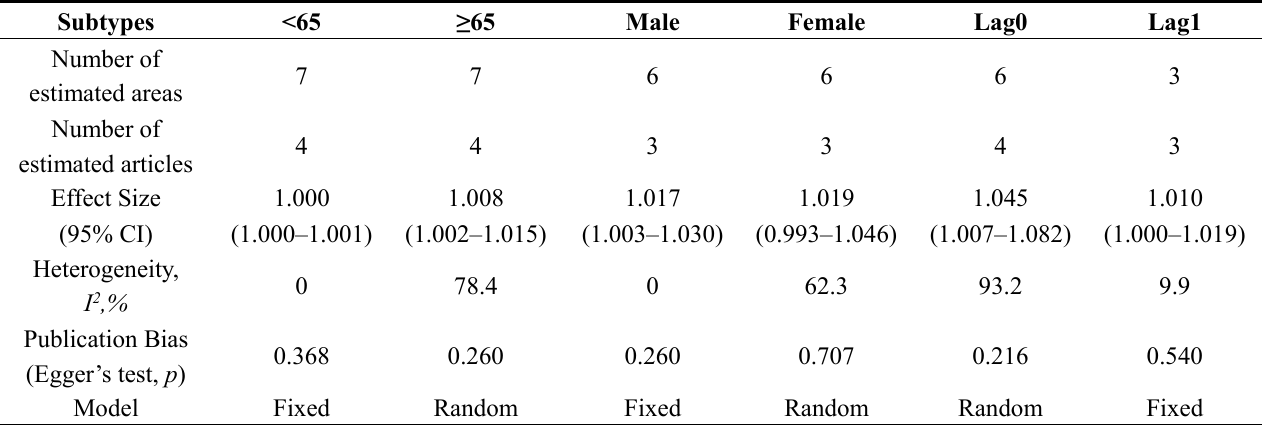
Table 3. Sensitivity Analyses for Hot Effects.